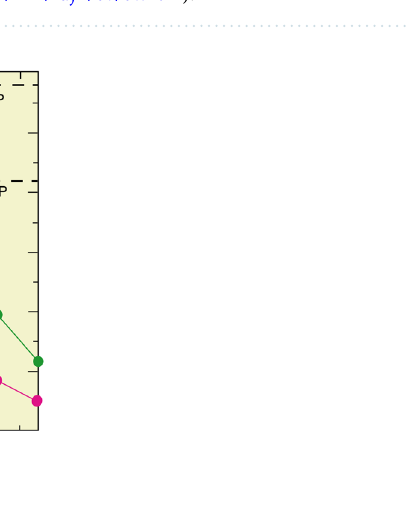
Figure 8. Calculated subsidence (m) considering Young’s modulus of ( a ) 5 GPa ( b ) 3 GPa ( c ) 1 GPa with a logarithmic decrement. (ev ver5.01 http:// fubuki. g1. xrea. com/ rml/ fujii/ ev/ ev. htm).